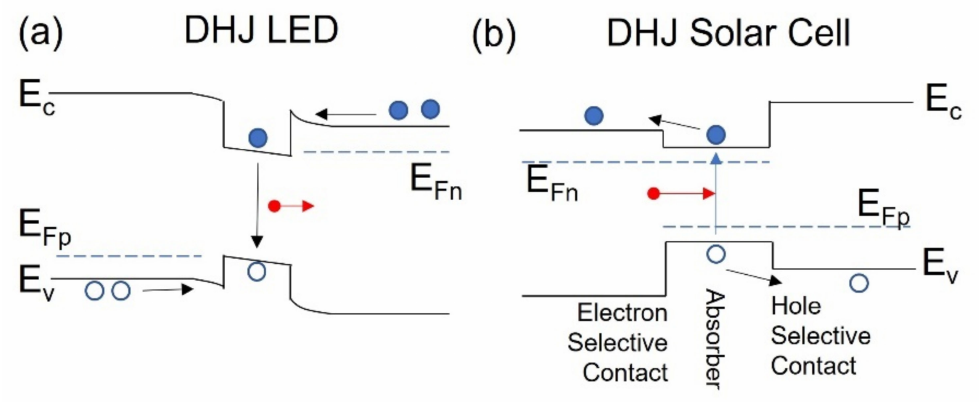
Figure 2. ( a ) Energy band diagram of a forward biased DHJ LED with lattice matched wider band gap injection and narrow band gap active layers; ( b ) energy band diagram of a DHJ c-Si solar cell with asymmetric hetero